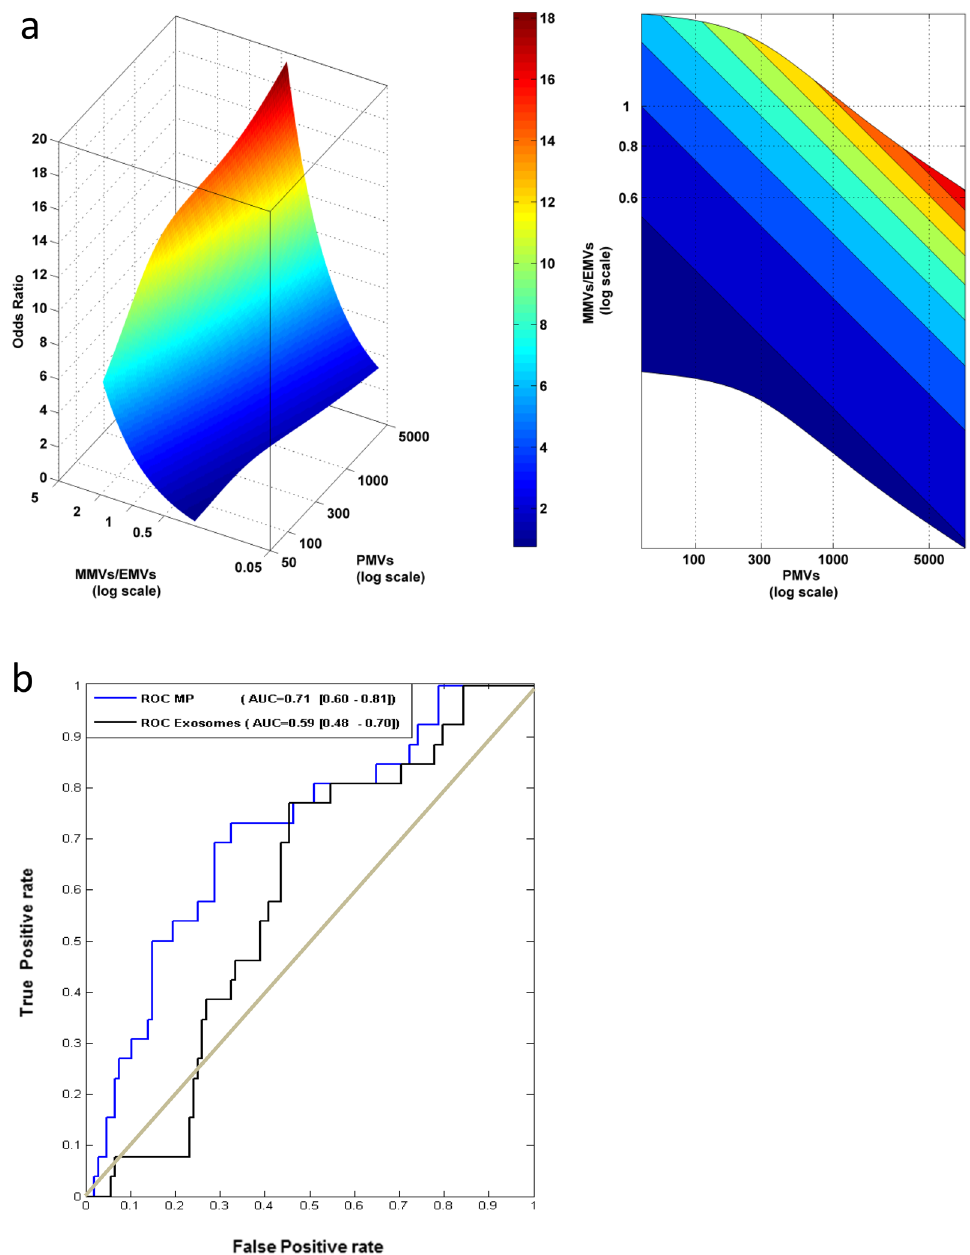
Figure 3. Risk prediction model for RB grade worsening. ( a ) Odds-ratio of the logistic model based on MVs illustrated as a bivariate function of PMVs, EMVs and MMVs. Left: 3D color map surface; right: contour projection in the XY plane. ( b ) Receiver operating characteristic (ROC) for the logistic model based on MVs data (blue) or exosomes (black) and their respective area under the curve (AUC) with 95% confidence intervals between